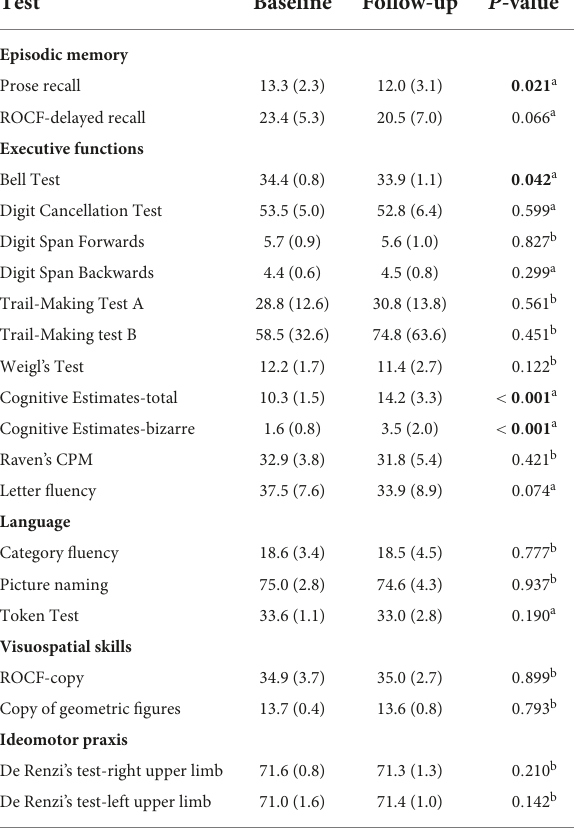
TABLE 1 Neuropsychological test scores at baseline and follow-up in subjects with NC at baseline ( n =